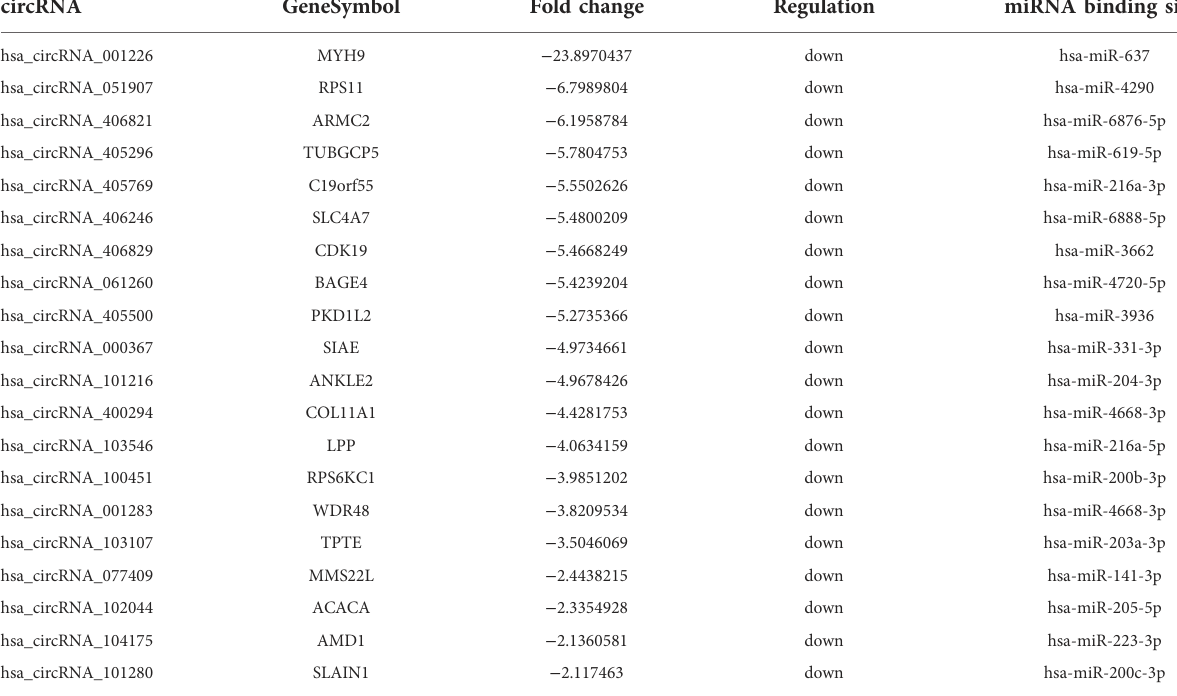
TABLE 1B 20 circRNAs signi fi cantly downregulated in wound of diabetic patients. circRNA Fold change